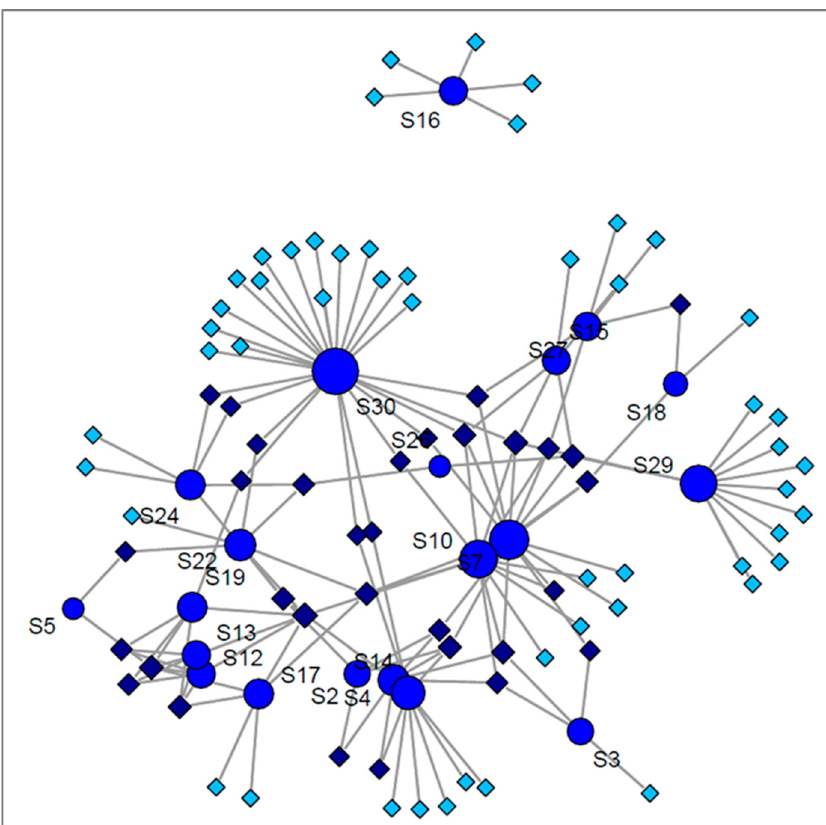
Figure 5. Network analyses of lung cancer studies distribution based on detected volatiles, where circles marked with S represent the number of the study, allotted similarly in Table 3; darker diamonds represent the common VOCs; pale diamonds depict the uncommon VOCs.